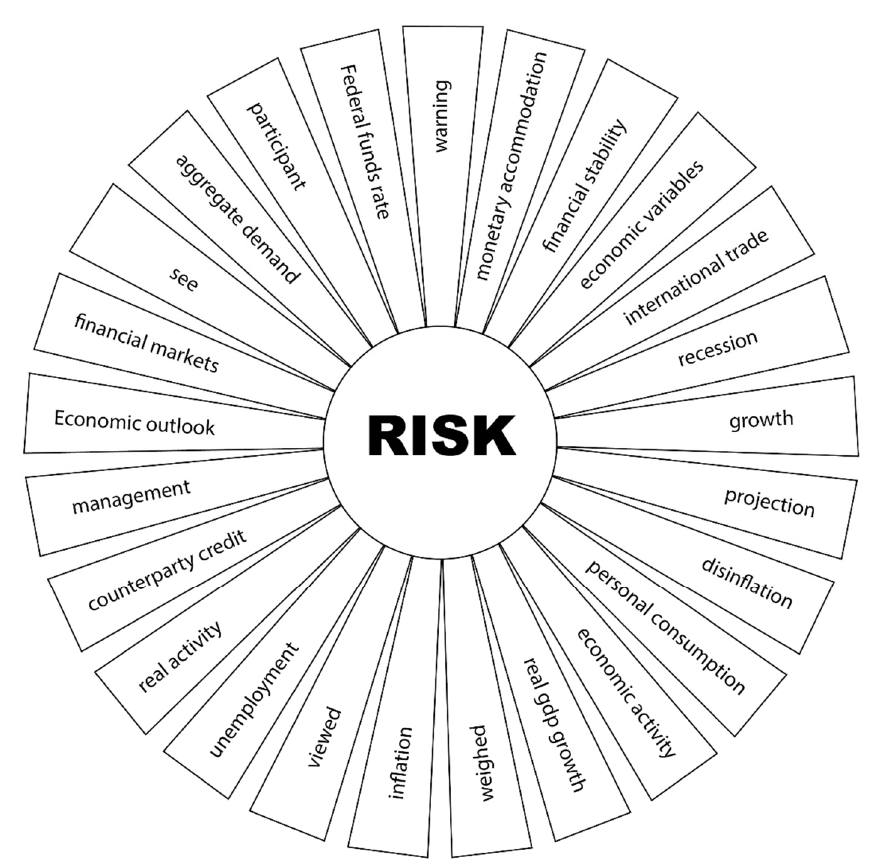
Figure 4. The network of the form “risk” of the U.S. Federal